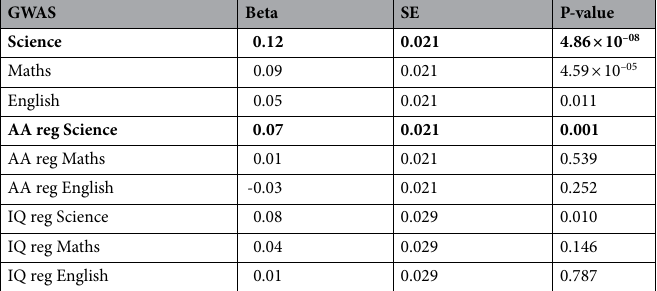
Table 5. Associations between rs9529641 and all nine GWAS phenotypes. Bolded figures show significant associations. For the first set of analyses genome-wide significance is p ≤ 5 × 10 –8 . Subsequent tests were hypothesis driven and therefore Bonferroni corrected to p ≤ 0.008